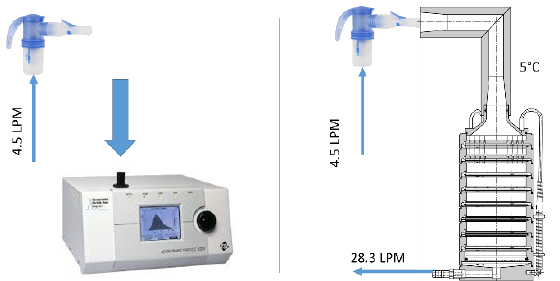
Fig . 1 . Schema of the measurement rig: APS measurement (left), ACI measurement